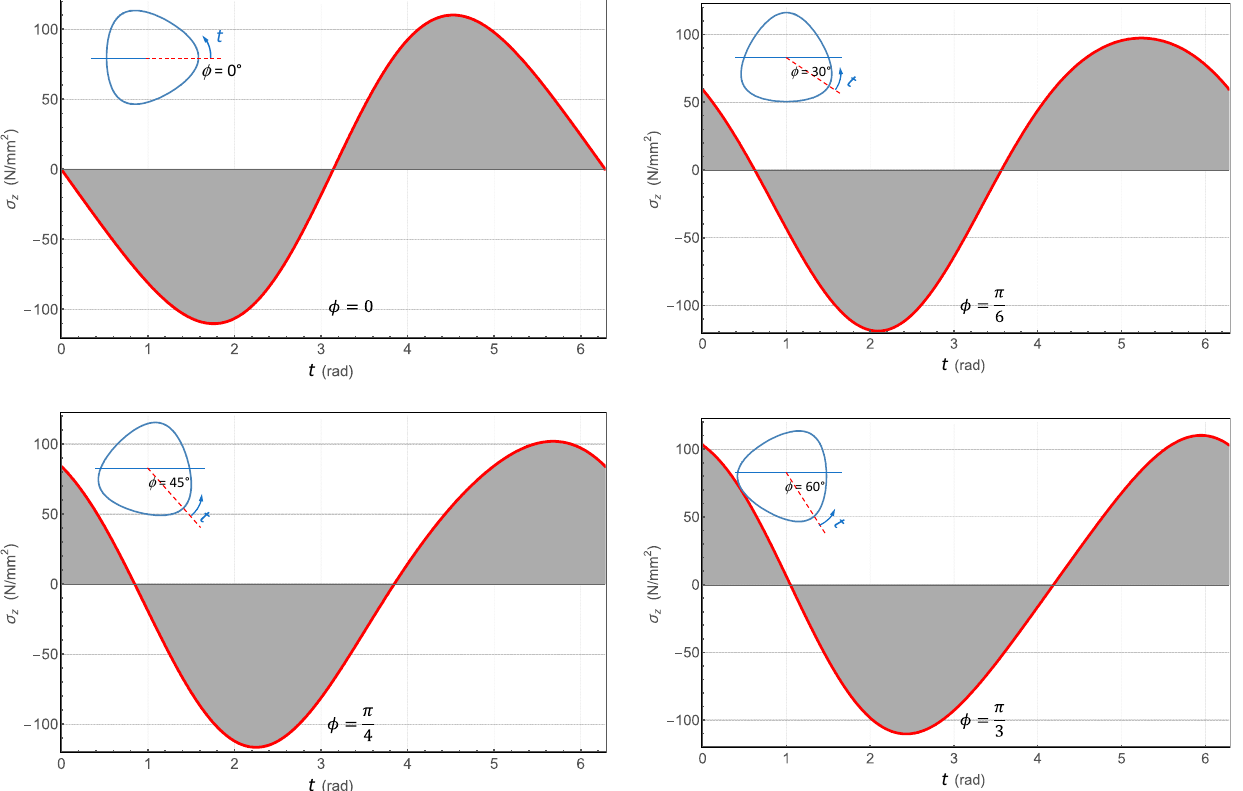
Figure 12. Distributions of the bending stresses on the profile contour for different angles of rotation φ , with r = 18.18 mm, n = 3, e = 1.818 mm, and M b = 500 Nm. 2.9. Deflection